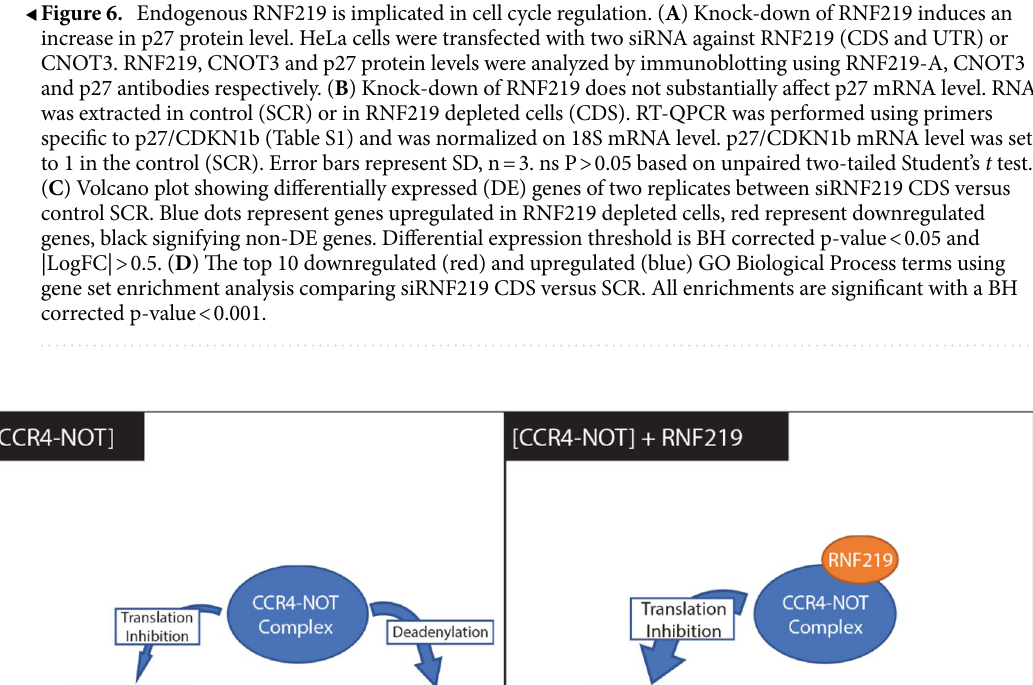
Figure 7. Schematic representation of RNF219 function. Recruitment of RNF219/CCR4-NOT complexes leads to mRNA translational repression in the absence of poly(A) tail Data availability RNA-sequencing data have been deposited in GEO under the accession number GSE95442. All raw data used for mRNA quantification and luciferase activities are available in Table S5, along with all associated statistical analyses.